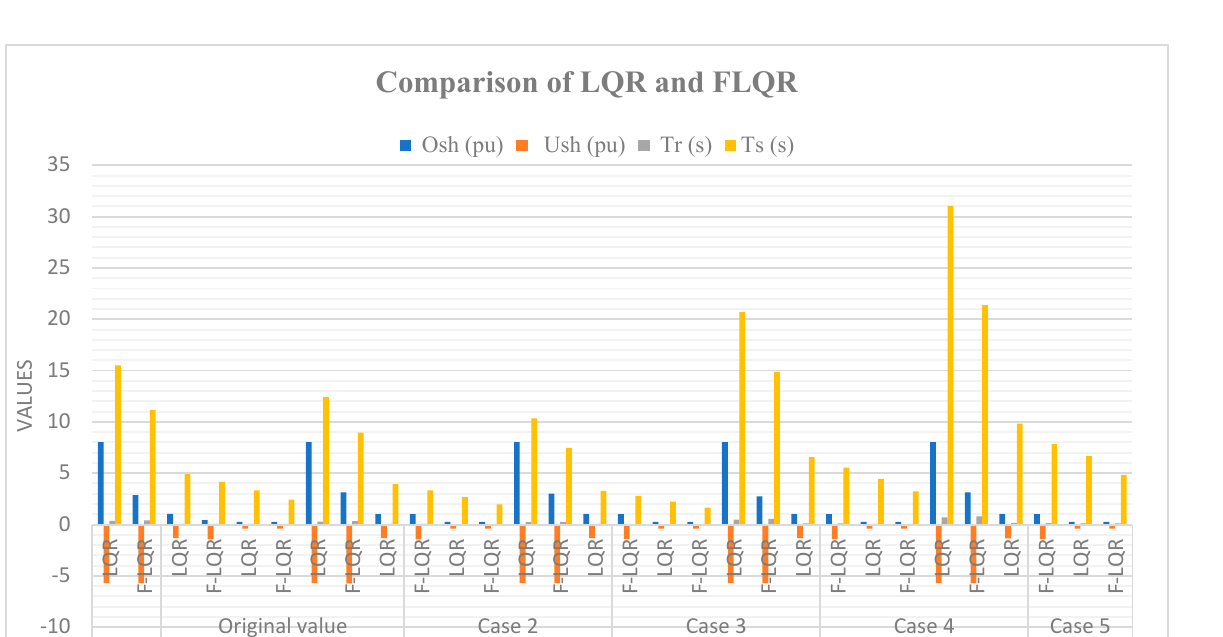
Figure 18. LQR and FLQR comparison.